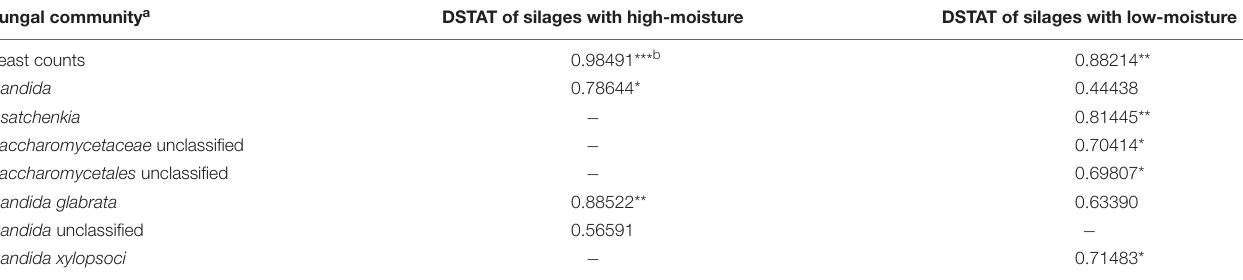
TABLE 2 | Correlations between the degree of silage temperature ( ◦ C) above ambient temperature (DSTAT) and the fungal community in whole-plant corn silages. Fungal community a